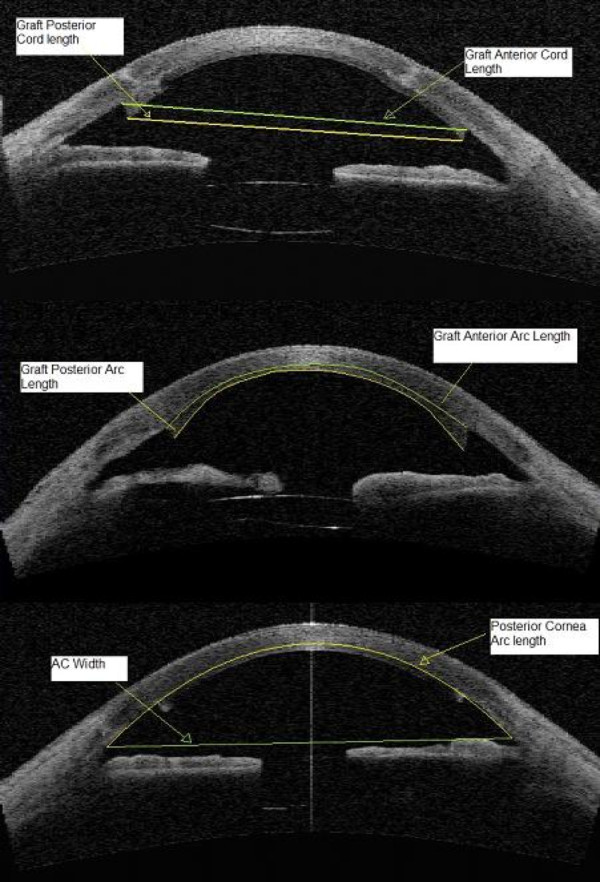
ASOCT image with markings and measurements.